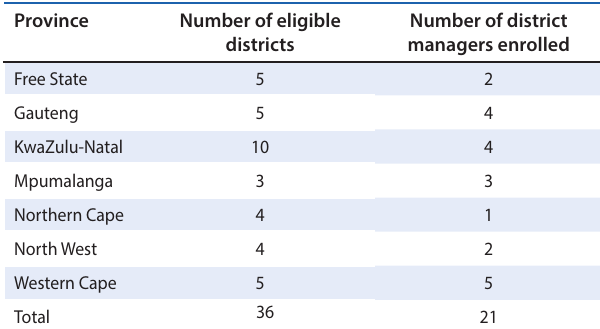
Table 1: Interview guide Table 2: Enrolment of district managers by